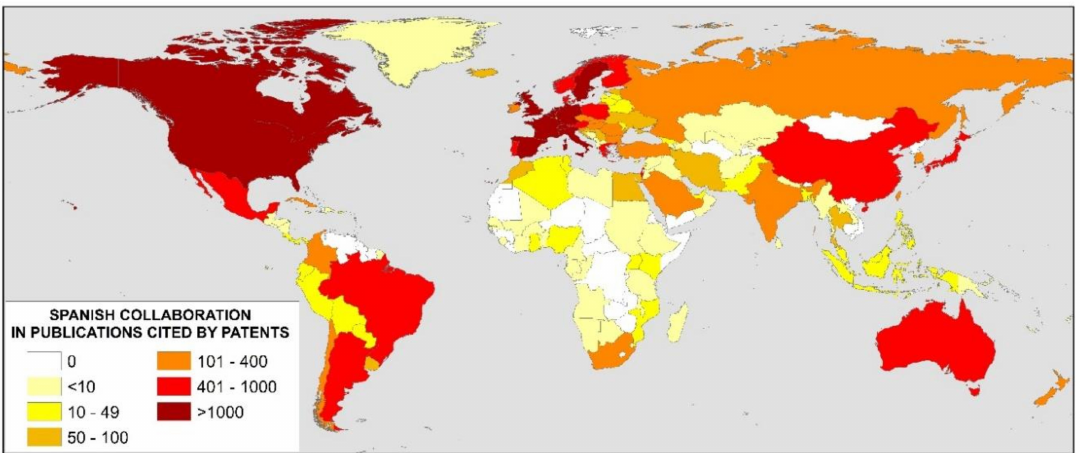
Figure 3. Worldwide collaboration with Spanish publications cited in